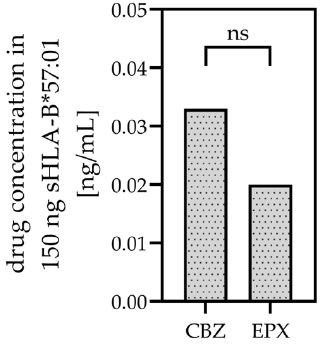
Figure 1. CBZ and EPX concentration on sHLA-B*57:01 molecules post CBZ or EPX treatment. 150 ng affinity purified sHLA-B*57:01 molecules post drug treatment were measured in four replicates ( n = 4) by